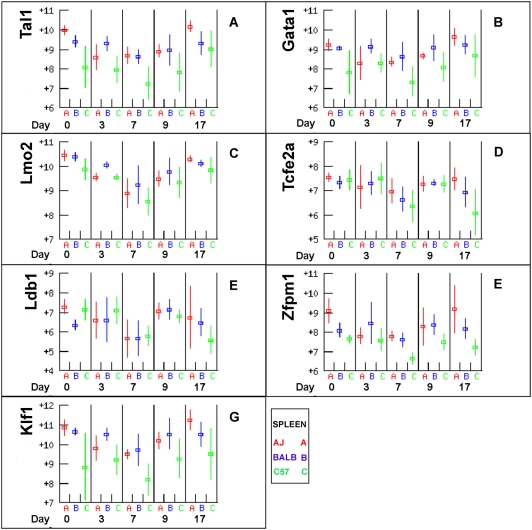
Transcription factors regulating erythropoiesis.
Tal1, Gata1, Lmo2, Ldb1, TcfE2a and Zfpm1 (Fog1) form a multimeric DNA binding complex, which regulates primitive haematopoiesis. All six genes were highly expressed and had similar patterns of expression consistent with co-ordinate regulation. Klf1 is involved in erythroid cell proliferation and had similar levels and patterns of expression suggesting that it may be regulated by the same mechanisms. In all cases C57BL/6 mice tended to have the lowest levels of expression after day 3.